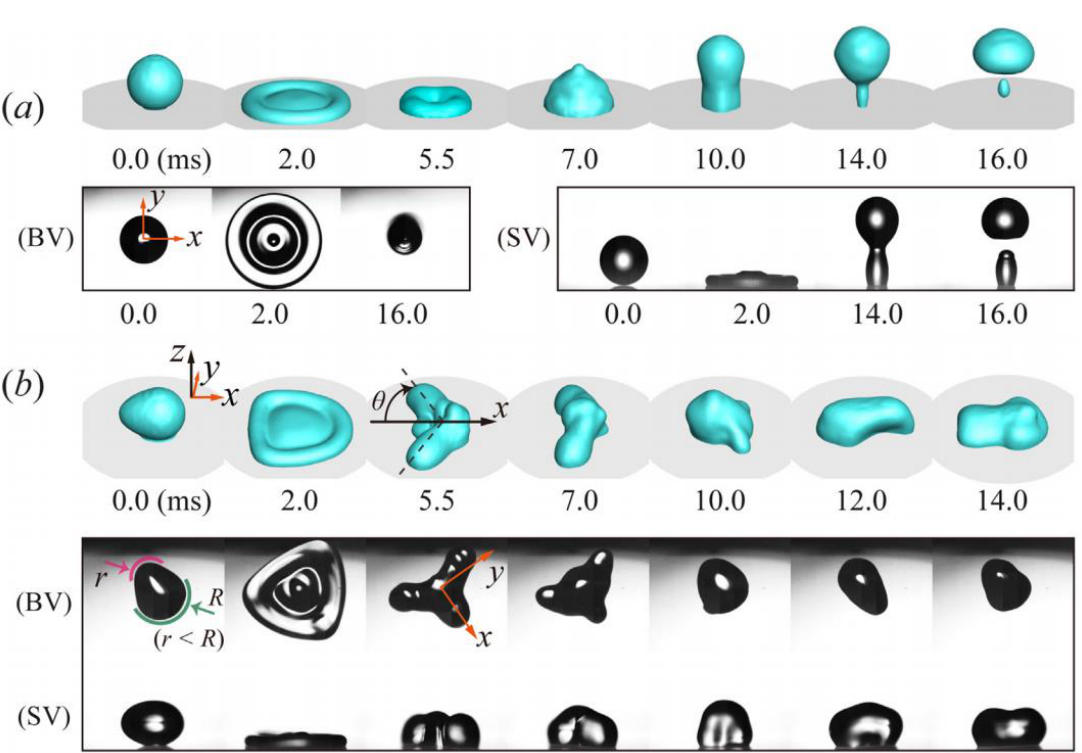
Figure 7. Simulation and experimental snapshots of the impact dynamics of ( a ) spherical and ( b ) asymmetric droplets on a hydrophobic surface (reproduced with permission from [109]); the equivalent droplet diameter is 2 mm and We = 17. SV and BV stand for the side and bottom-views in the experiment, respectively.